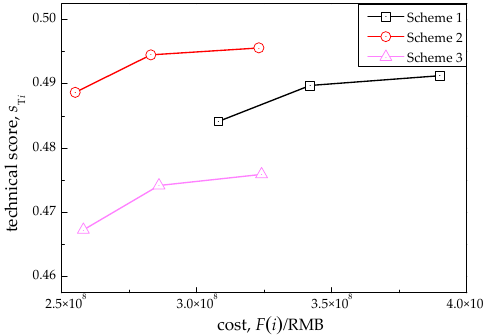
Figure 9. Technology-cost curves of Scheme 1, Scheme 2, and Scheme 3.